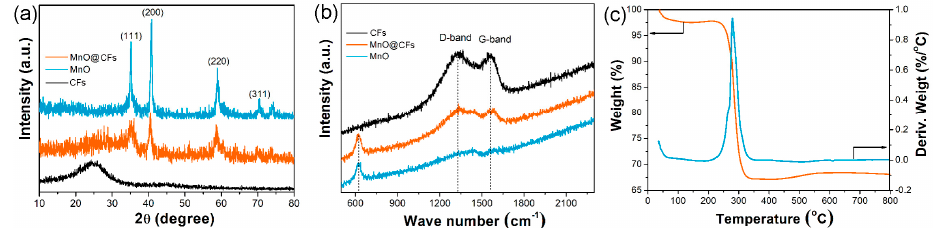
Figure 1. Schematic illustration of preparation of MnO nanoparticles anchored on carbon fibers (MnO@CFs).